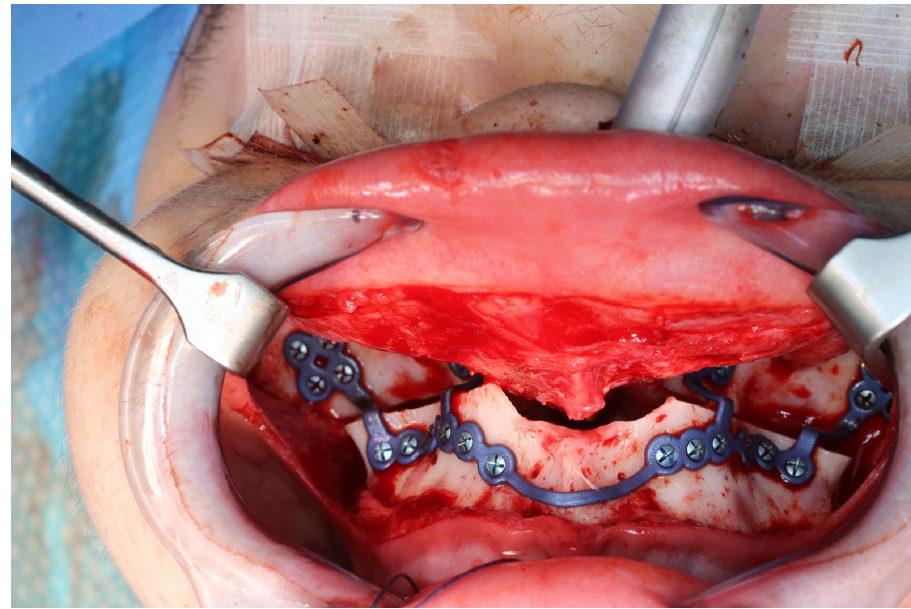
Figure 11. Upper jaw positioned and fixed by means of patient-specific implant.